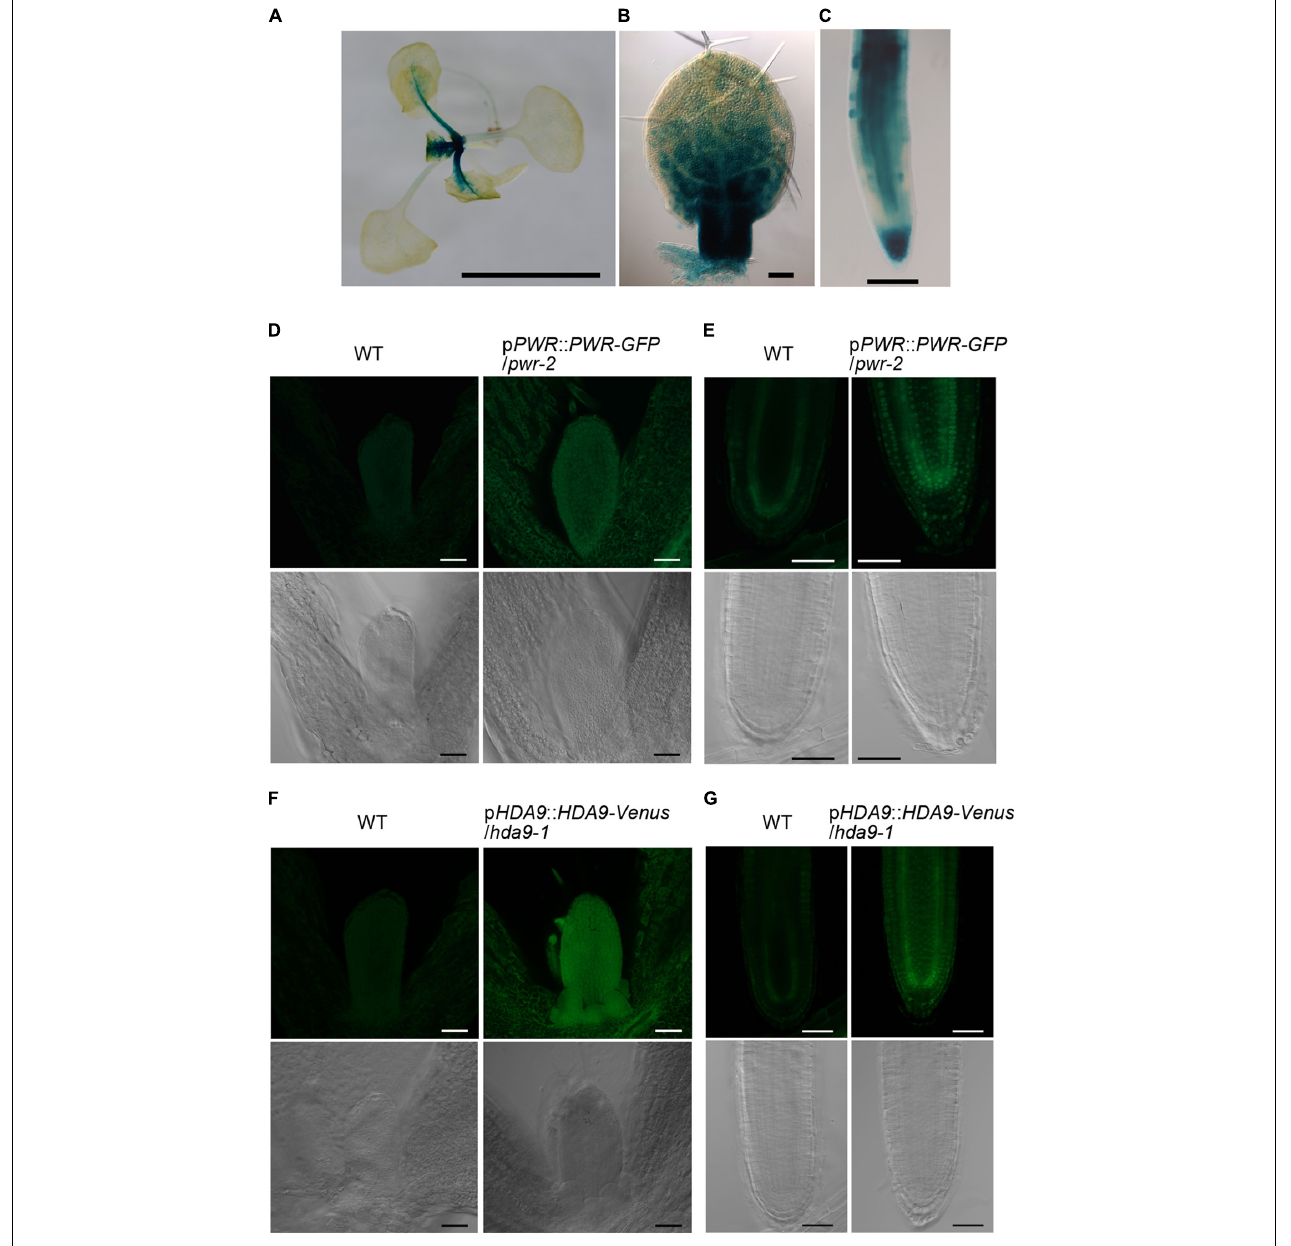
FIGURE 5 | Expression patterns of HOS15 , HDA9 , and PWR and intracellular distribution of HDA9 and PWR. (A–C) Histochemical GUS staining of p HOS15 :: GUS plants. (A) A 14-day-old plant grown on rockwool. (B) First leaf primordium of an 8-day-old plant. (C) Primary root tip of a 7-day-old plant grown in vitro . (D , E) A 4-day-old p PWR :: PWR-GFP / pwr-2 plant grown in vitro . (F , G) A 4-day-old p HDA9 :: HDA9-Venus / hda9-1 plant grown in vitro . (D , F) Shoot tips. (E , G) Root apical meristems. In (D–G) , WT plants were observed as a negative control and are shown in the left two panels. Images of transgenic plants carrying the PWR-GFP or HDA9-Venus construct are shown in the right two panels. Fluorescent images are shown in the upper rows while differential interference contrast images are shown in the lower rows. Bars in (A) , and (D–G) indicate 5 mm and 50 µ m, respectively, while those in (B) and (C) indicate 100 µ